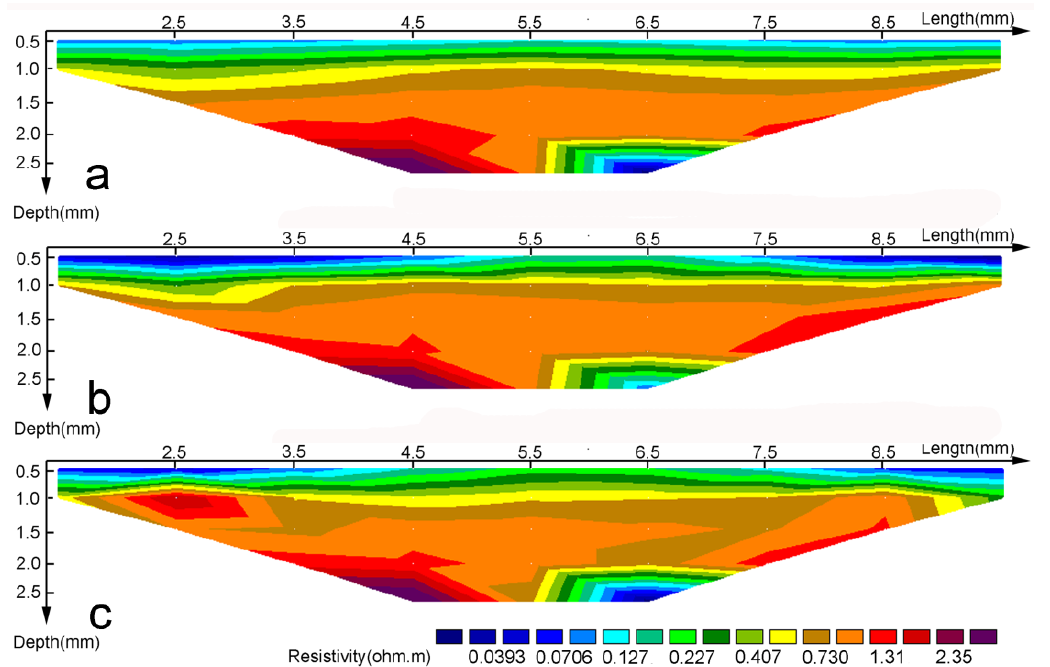
Figure 6. Inversion images of the observed apparent resistivity for side A on 10 Ah battery under three different temperatures ( a ) 0 °C; ( b ) 25 °C; and ( c ) 50 °C. The images reflect the changes of resistivity pseudosection with